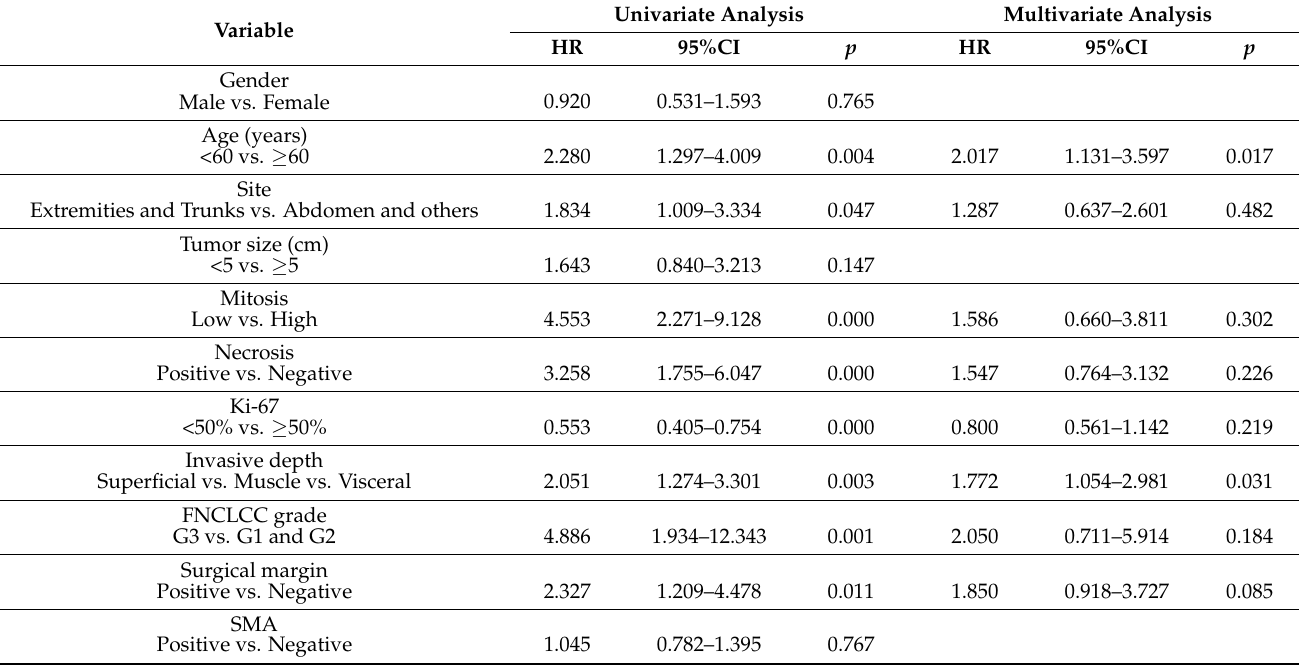
Table 2. Univariate and multivariate analyses of clinicopathological features and overall survival in UPS patients. Univariate Analysis Multivariate Variable